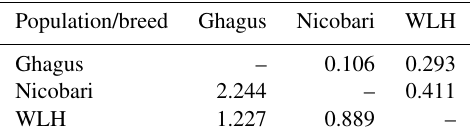
Table 3. Percentage of homozygous and heterozygous individuals among three breeds. Breed Ghagus Nicobari WLH Status No. % No. % No. % Heterozygous 100 84.03 72 57.60 59 49.58 Homozygous Total